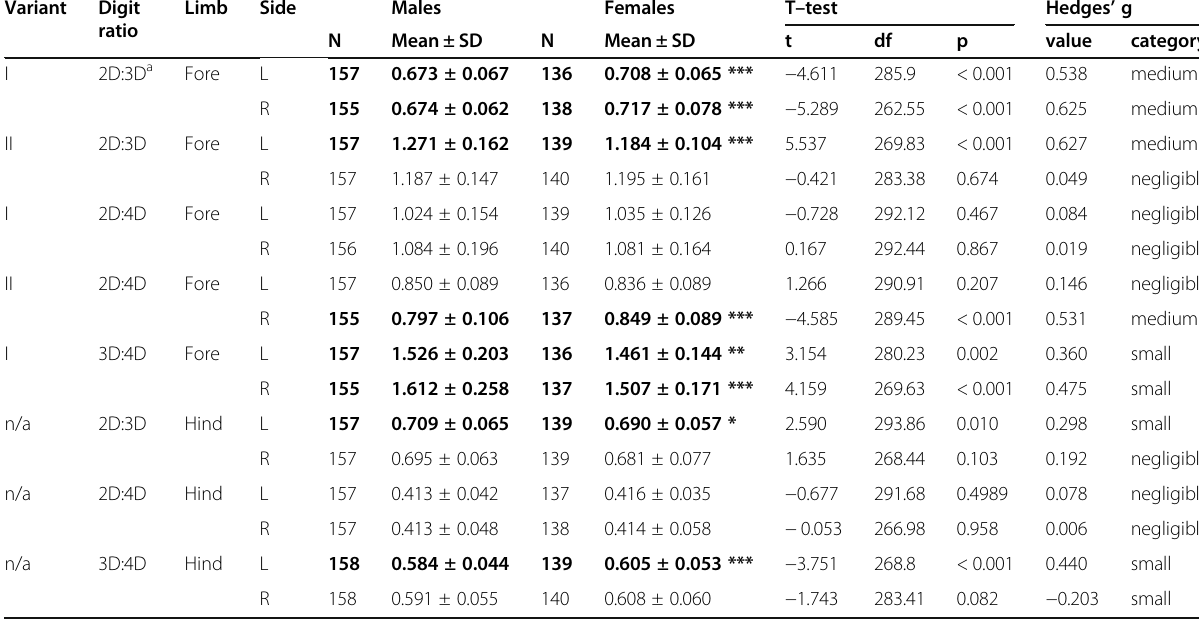
Table 2 Comparison of digit ratios (2D:3D, 2D:4D, and 3D:4D) on the forelimbs and hindlimbs between adult males and females of the common toad Bufo bufo, according to both forelimb digit numbering protocols (variants I and II). The last two columns present estimated absolute values of the effect size according to Hedges ’ g statistics with magnitude categories